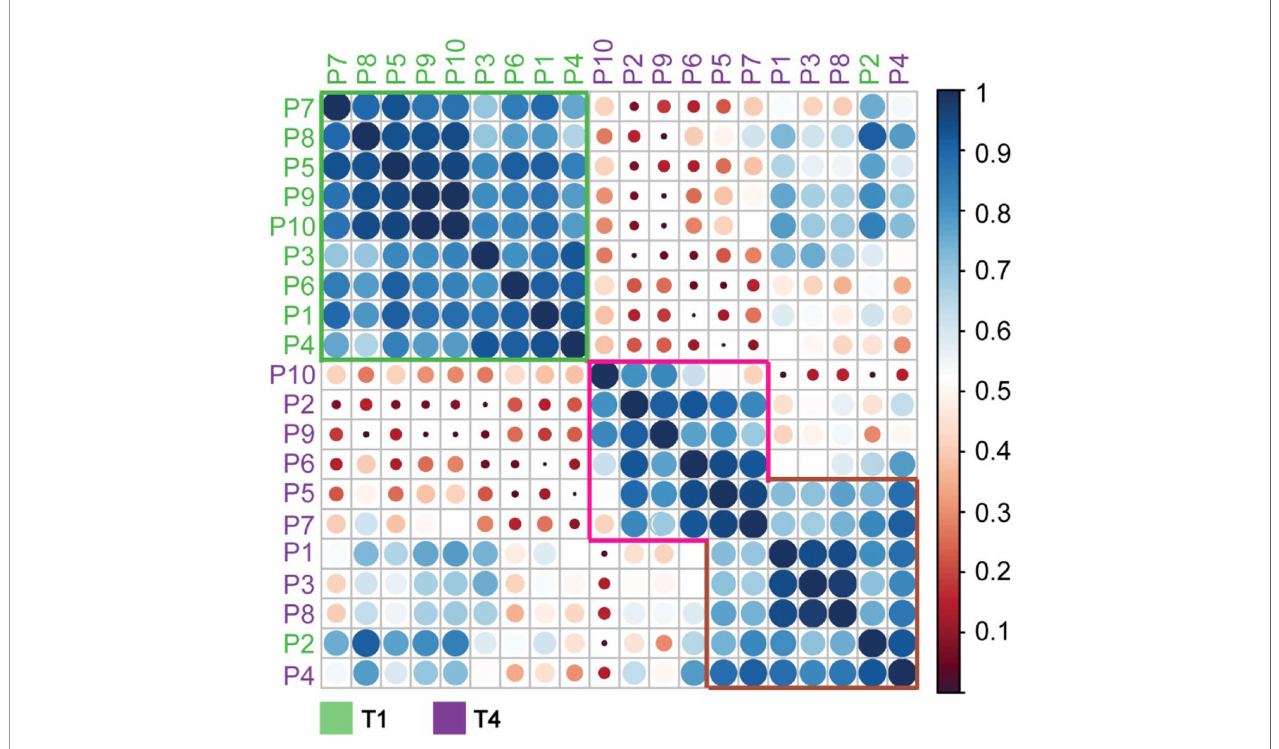
FIGURE 5 | Correlation matrix of a -1-antichymotryspin glycoproteoform pro fi les for all individual patients at time points T1 and T4. Native mass spectra for each patient and time-points were correlated with each other and clustered based on the Pearson correlation. Patients are color-coded according to the time-point with green corresponding to T1 and red to T4. Highlighted are three distinctive clusters coming out of this analysis: green, purple, and brown. The most likely feature distinguishing these clusters is the average weighted masses, which increase for the data from the green box, via the brown to the pink